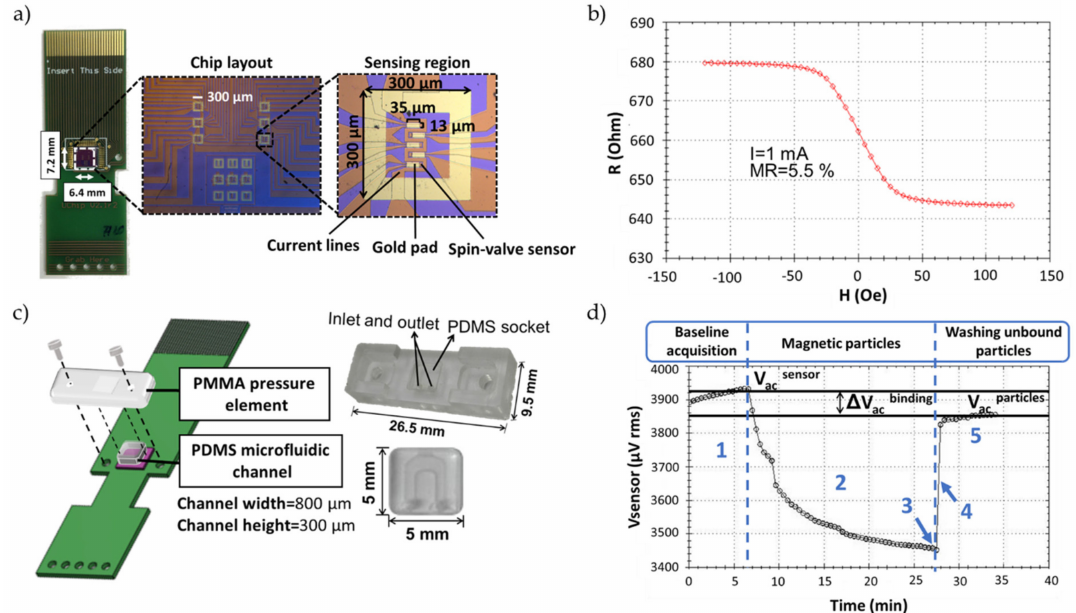
Figure 1. ( a ) Biochip (7.2 × 6.4 mm 2 ) encapsulated in a printed circuit board (PCB) chip carrier. ( b )